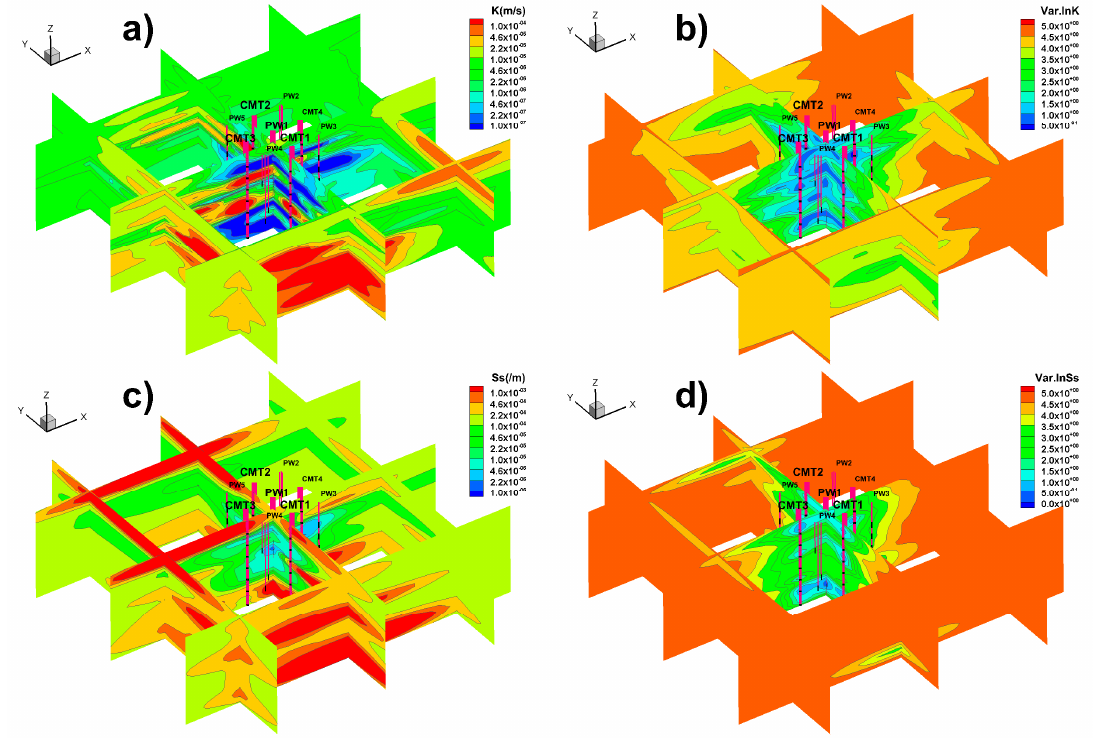
Figure 3. The estimated tomograms of ( a ) K and ( c ) S s and corresponding variances of ( b ) ln- K and ( d ) ln- S s obtained from transient hydraulic tomography (THT) analysis of 14 pumping tests.